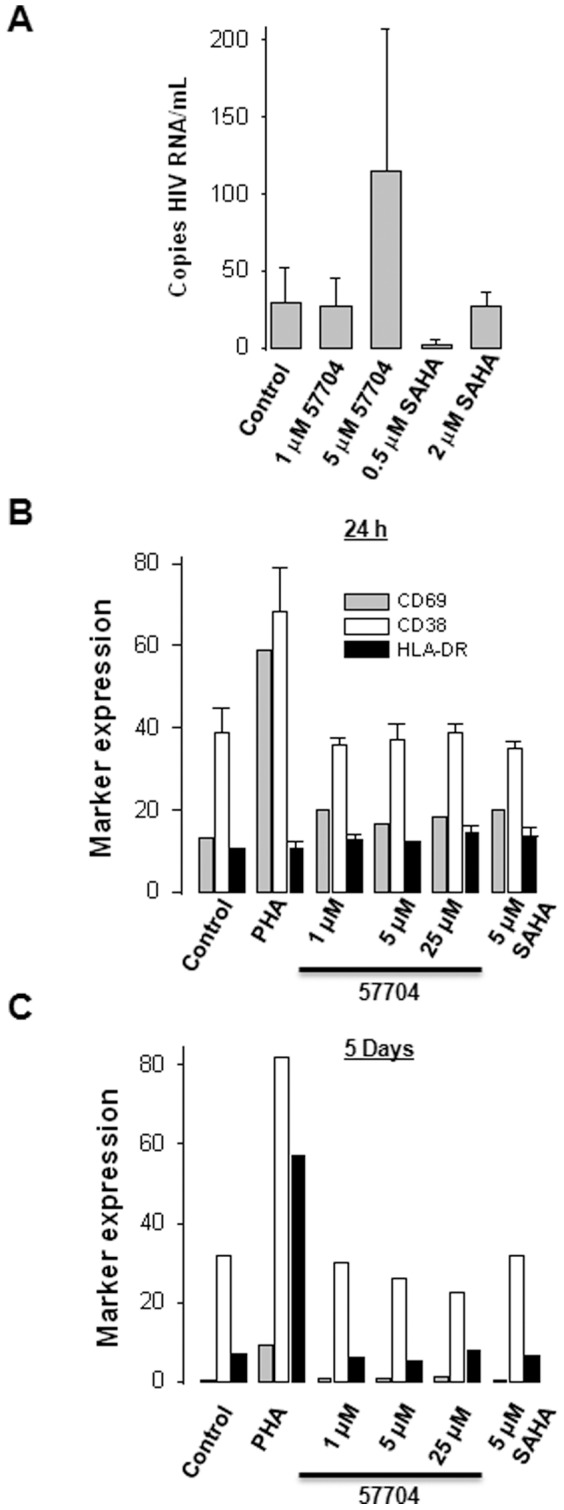
Latent HIV-1 reactivation activity of 57704 and T cell activation in CD8+-depleted MNC.(A) Quantitation of cell-free HIV-1 RNA in the culture supernatants of CD8+-depleted blood MNC incubated with 57704 or SAHA. (B) Surface expression of CD69, CD38 and HLA-DR after 24 h in purified T cells following exposure to 10 µg/mL PHA, 57704 or SAHA. (C) Surface expression of CD69, CD38 and HLA-DR after 5 days in purified T cells following exposure to 10 µg/mL PHA, 57704 or SAHA.